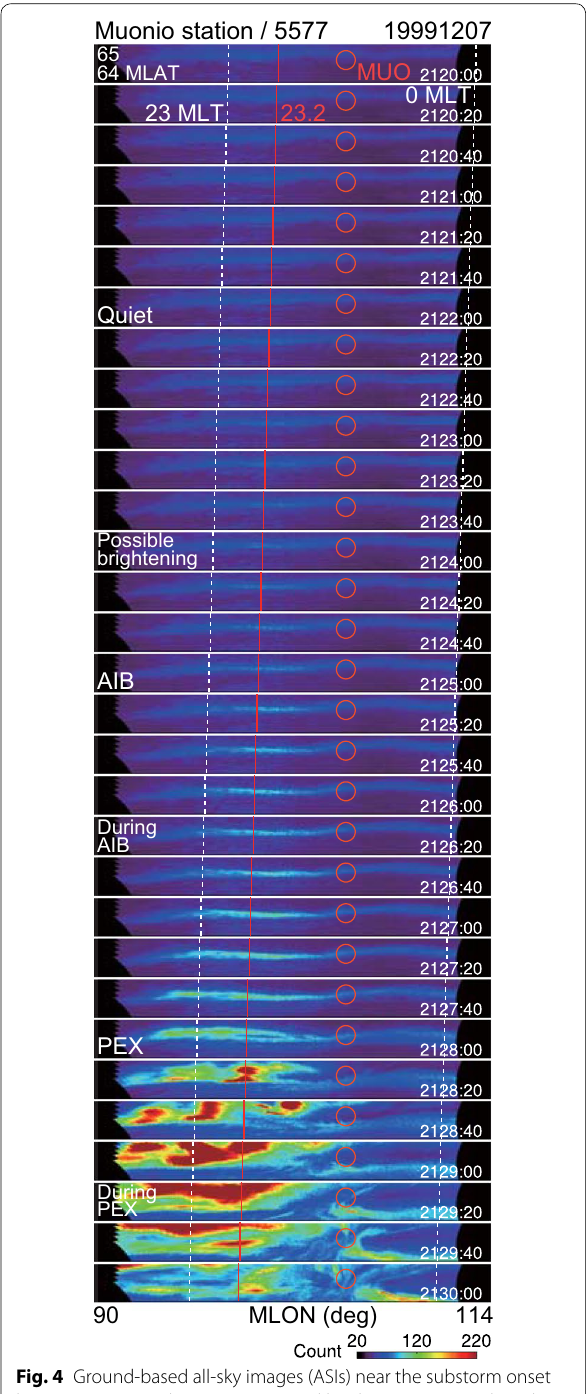
Fig. 4 Ground-based all-sky images (ASIs) near the substorm onset location on December 7, 1999. Auroral brightness at a wavelength of 557.7 nm (green-line) observed at Muonio (MUO) in Finland is shown. Time sequence of full-time-resolution (20-s) images from top to bottom in MLON–MLAT coordinates between 64 and 65 MLAT. The red circle indicates the location of MUO. The red line indicates 23.2 MLT, the approximate location of the initiation of the Akasofu initial brightening (AIB) and the poleward